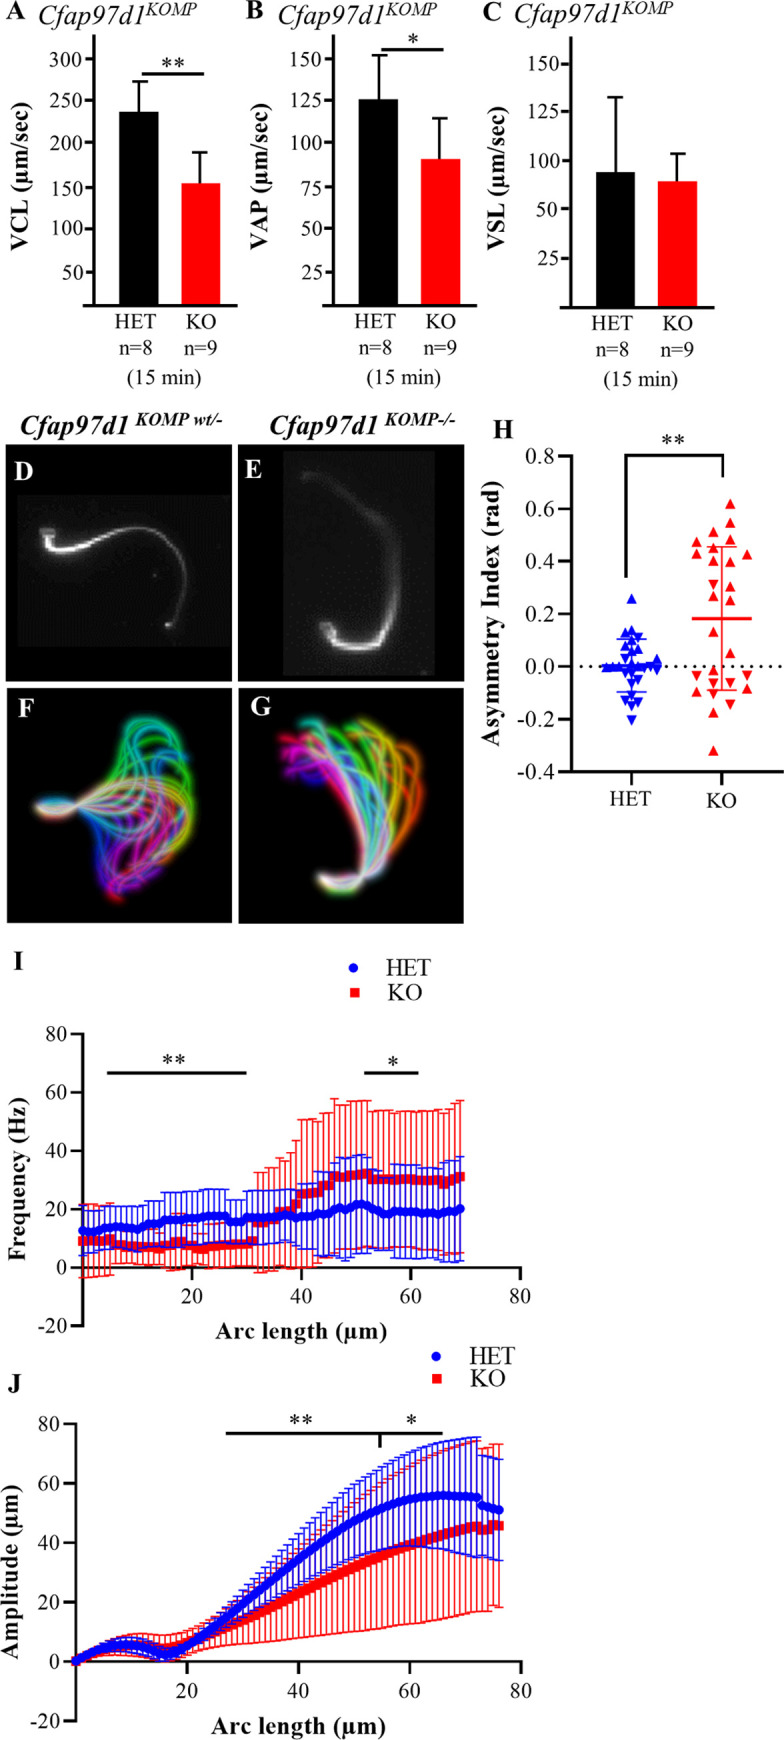
Sperm motility is altered in Cfap97d1KOMP-/- mice.(A) Curvilinear velocity (VCL) and (B) average path velocity (VAP) values were reduced in Cfap97d1KOMP-/- sperm. (C) The straight-line velocity (VSL) was not changed in Cfap97d1KOMP-/- sperm. (D, E) Example of Cfap97d1KOMPwt/-
(D) and Cfap97d1KOMP-/-
(E) sperm flagellum bending modes. (F, G) Representative image of the flagellar movement waveform in tethered Cfap97d1KOMPwt/-
(F) and Cfap97d1KOMP-/-
(G) sperm. (H) Asymmetry index of flagellar beat in radians, determined by the median curvature angle values. Data represent the average of 0–50 μm arc length for each cell. Positive values indicate anti-hook conformation and negative values indicate pro-hook conformation. (I) Average primary beat frequency at each arc-length position indicates lower bending frequency of Cfap97d1KOMP-/- sperm in the neck region (red line). Statistical significance occurs at 5–30 μm (**P ≤ 0.01) and 52–64 μm (*P ≤ 0.05). (J) Amplitude of the flagellar beat compared to head-midpiece axis in the Y- direction indicates decreased sperm flagellar moving amplitude in Cfap97d1KOMP-/- (red line). Significant differences were observed from 29–56 μm (**P ≤ 0.01) and 57–67 μm, (*P ≤ 0.05). (H-J) Total analyzed cells = 27, from three mice of Cfap97d1KOMPwt/- and Cfap97d1KOMP-/-. *P < 0.05, **P < 0.01, Student’s t-test, (±SD).